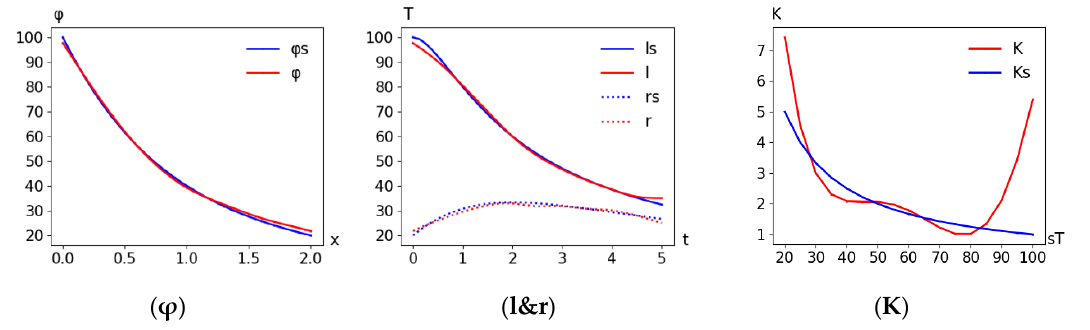
Figure 7. SvF solution of Problem 5.4: ( φ ) the initial condition; ( l&r ) boundary conditions; ( K ) the thermal conductivity coefficient.